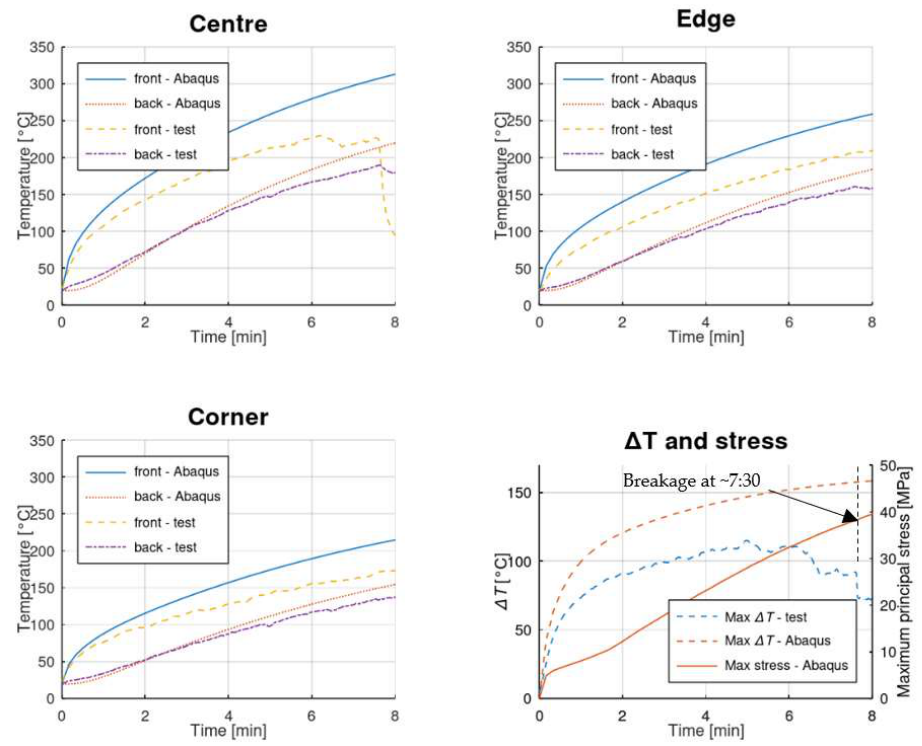
Figure 19. 3D model vs. test results for 12 mm glass pane (Test #3).